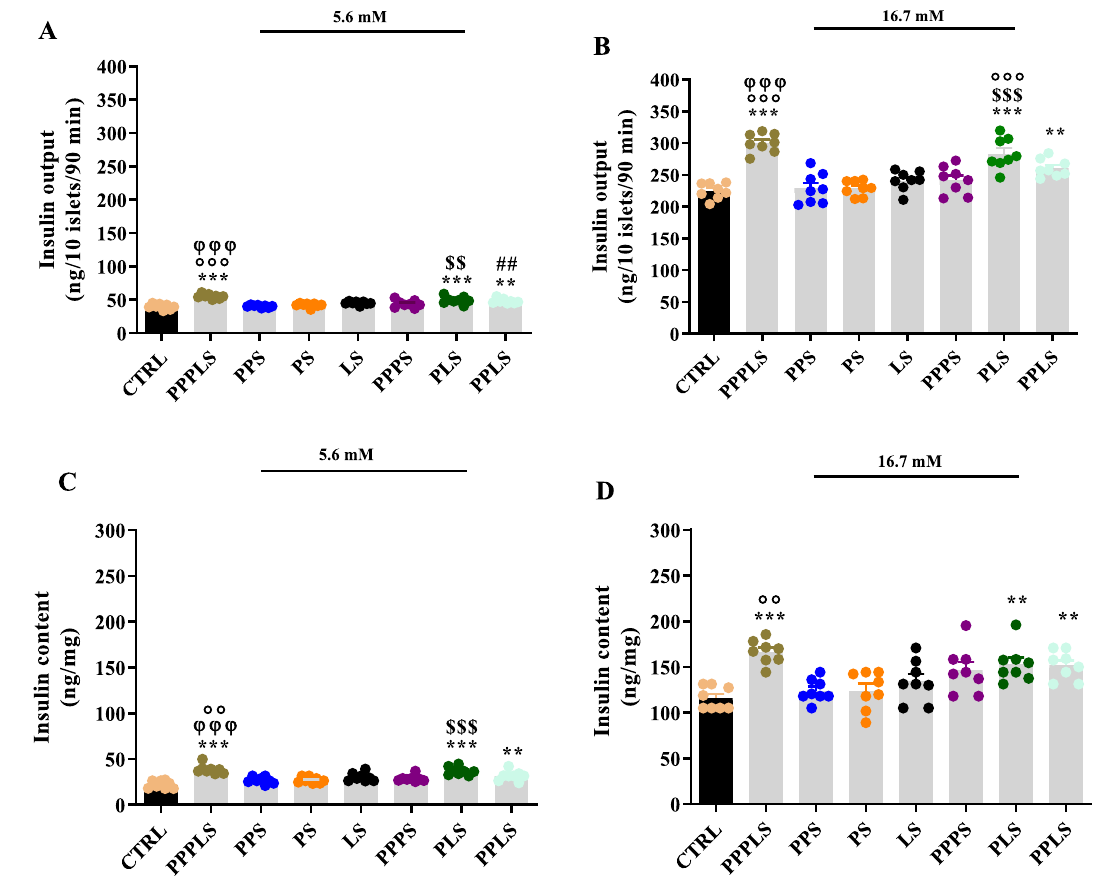
Figure 4. Effect of perinatal stress on the isolated islets insulin secretion ( A , B ) and insulin content ( C , D ) in response to 5.6 mM and 16.7 mM glucose concentrations in the young adult male offspring. Each column represents mean ± SEM (4 rats/group, 4 litters/group). Data was analyzed using one-way ANOVA followed by Tukey’s post hoc test; ** P < 0.01, *** P < 0.001 versus CTRL group; ## P < 0.01 versus PPS group; $$ P < 0.01, $$$ P < 0.001 versus PS group; οο P < 0.01, οοο P < 0.001 versus LS group; φφφ P < 0.001 versus PPPS group. CTRL non stress, PPPLS pre-pregnancy, pregnancy, lactation stress, PPS pre-pregnancy stress, PS pregnancy stress, LS lactation stress, PPPS pre-pregnancy, pregnancy stress, PLS pregnancy, lactation stress, PPLS